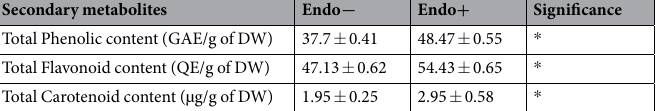
Table 2. Estimation of total phenolics, flavonoid and carotenoid content in endophyte treated and control plants of Crocus sativus . ( Endo − ) are the endophyte-free control and (Endo + ) are the endophyte treated Crocus plants. Values are the means of 3 biological replicates ± S.D. Comparisons among means were carried out